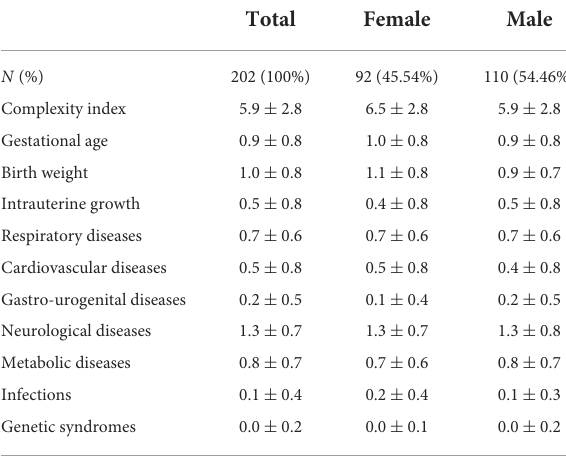
TABLE 5 Complexity index and its